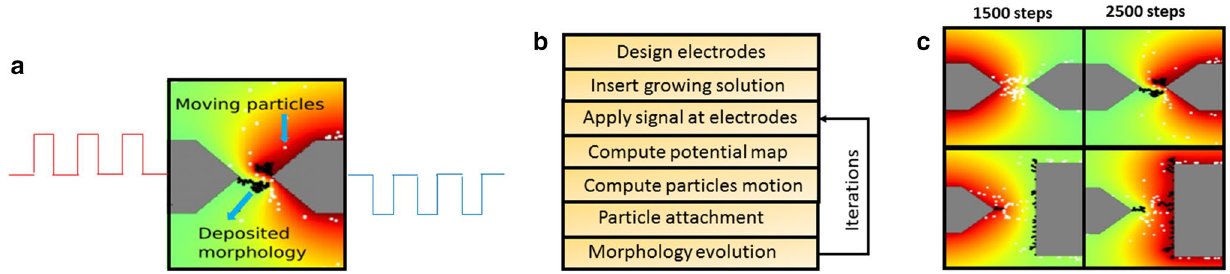
Fig. 7 Modeling of the dendritic growth process at 5 Hz and 20 Hz at different simulation steps ( a ). Fre- quency sweep of the growth in geometries with big and small electrode gap ( b ). Area occupied by the pixels associated with the fibers for different frequencies in the case of small ( c ) and big ( d ) electrode